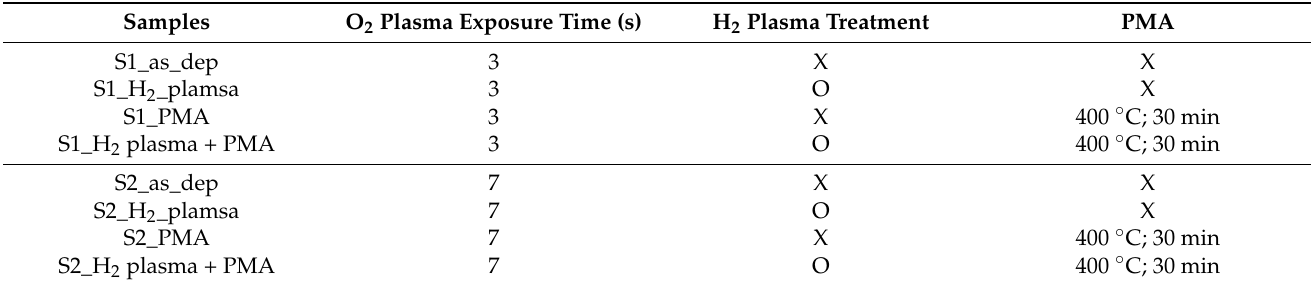
Figure 1. Process flow for the fabrication of the Al/Al 2 O 3 /Si gate stack. Table 1. Al 2 O 3 samples under deposition conditions (O 2 plasma exposure time: 3 and 7 s) and post- treatment conditions (H 2 plasma treatment and post-metallization annealing (PMA)).